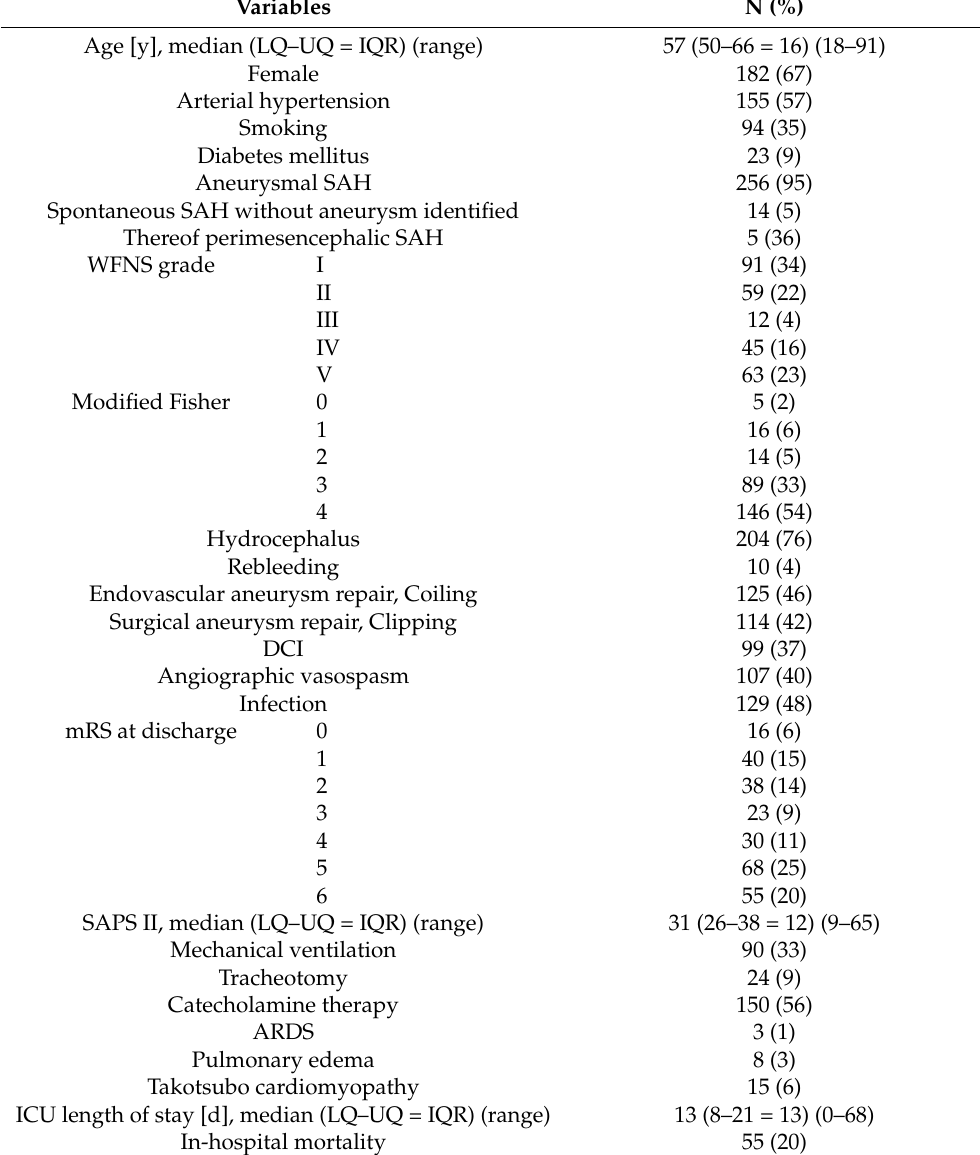
Table 3. Patient demographics and baseline characteristics of cohort with spontaneous SAH (N =